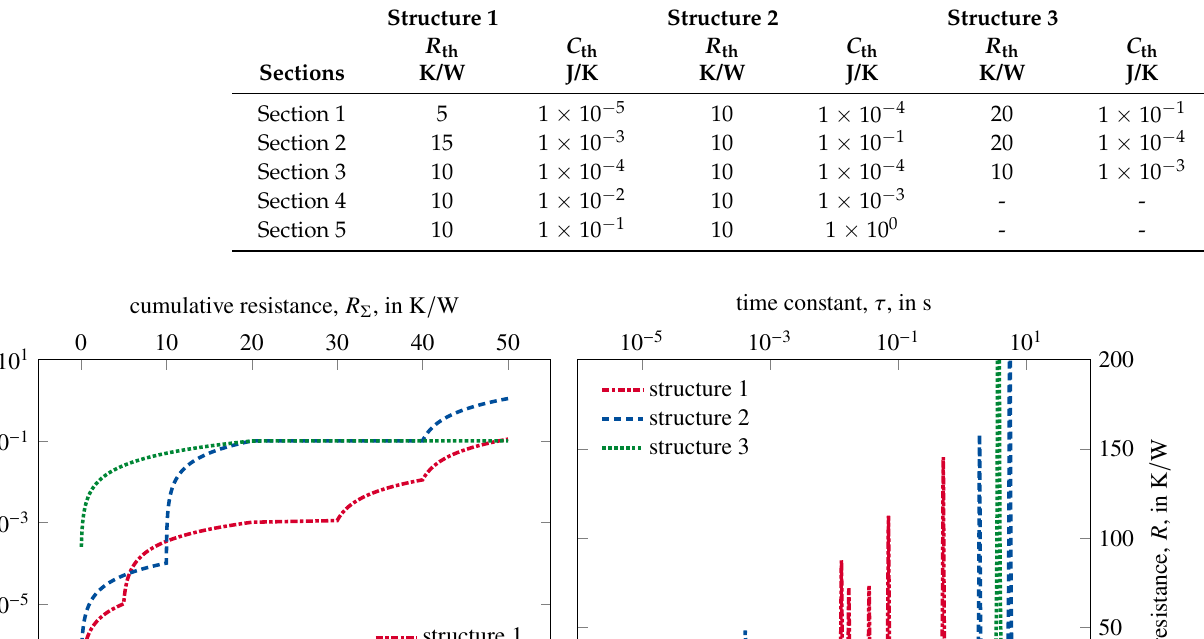
Table 1. Total thermal resistances and capacitances of the sections of the three piecewise uniform structure functions that serve as reference structures.